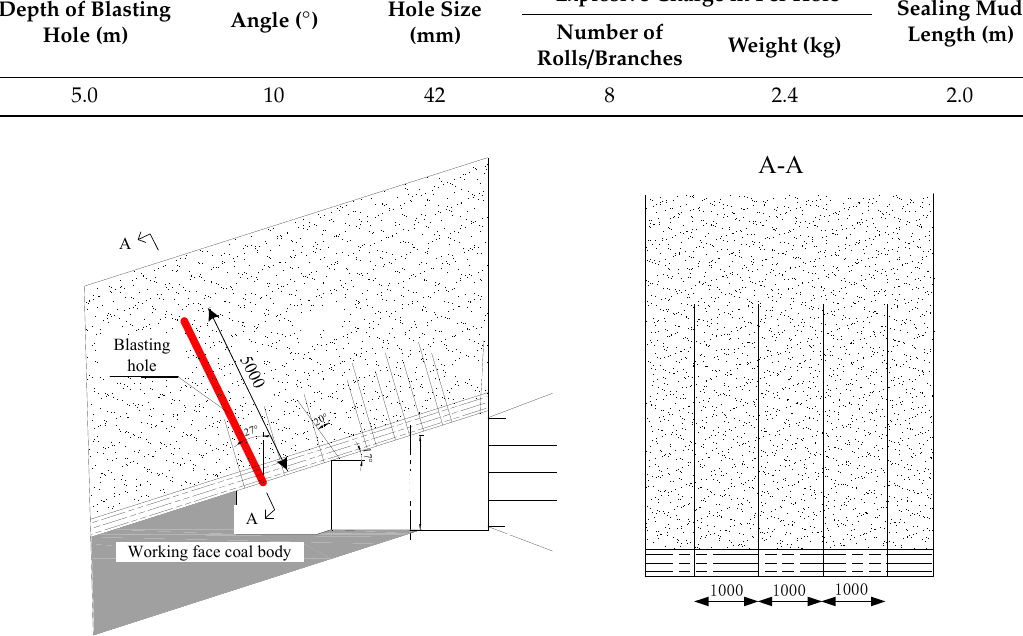
Figure 13. Diagram of shallow-hole blasting hole.